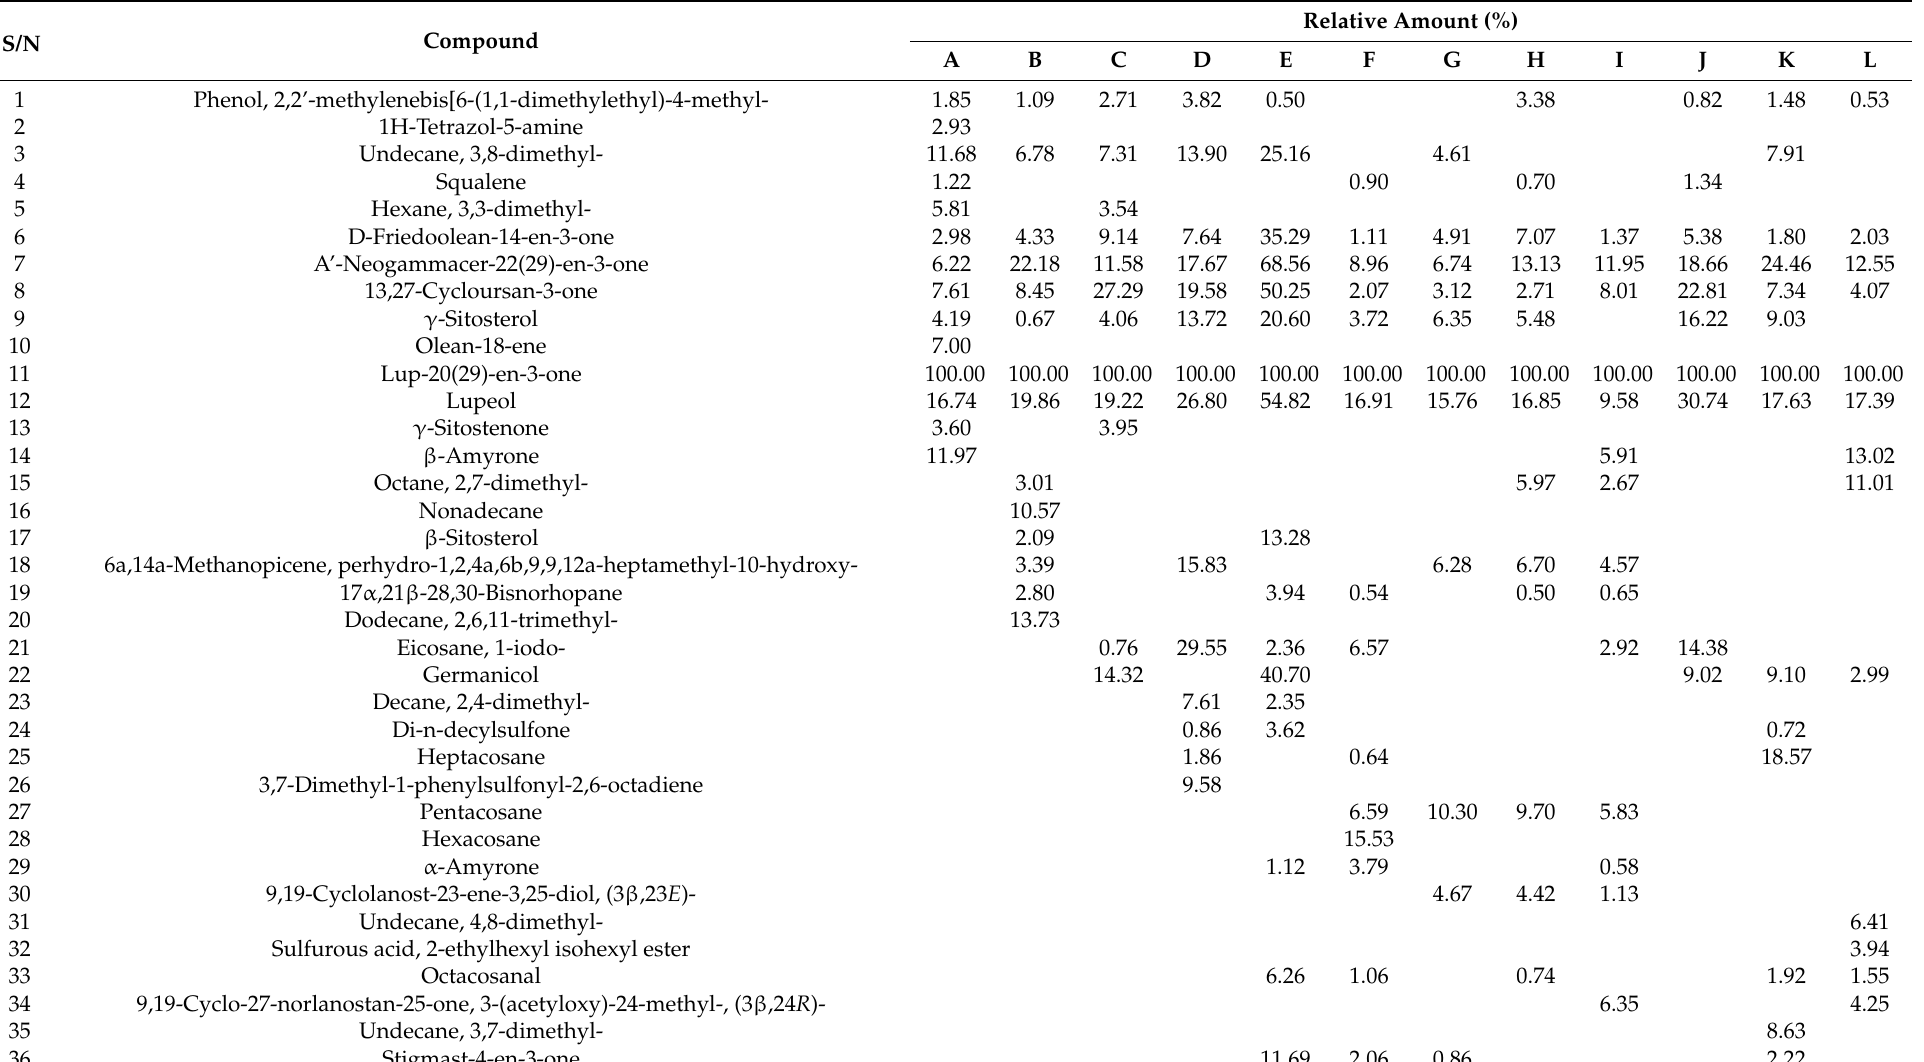
Table 4. Chemical compositions of the petroleum ether extractives of Alnus cremastogyne